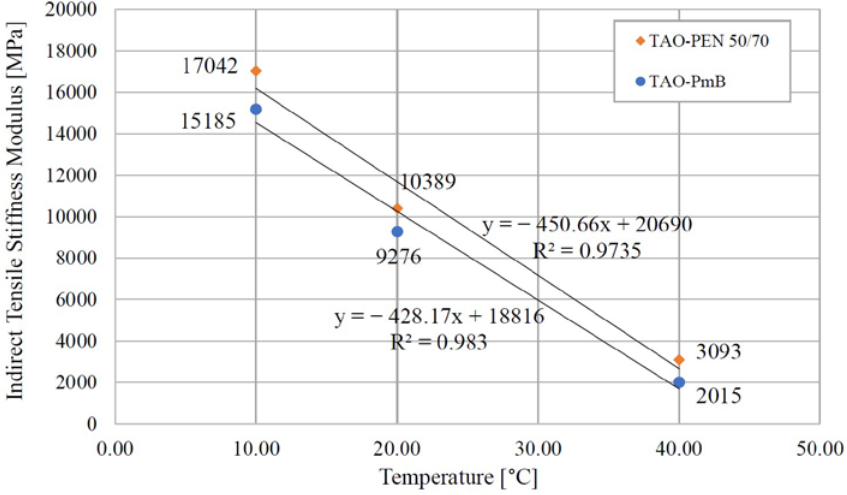
Figure 5. Average ITSM values of TAO–PEN 50/70 and TAO–PmB.